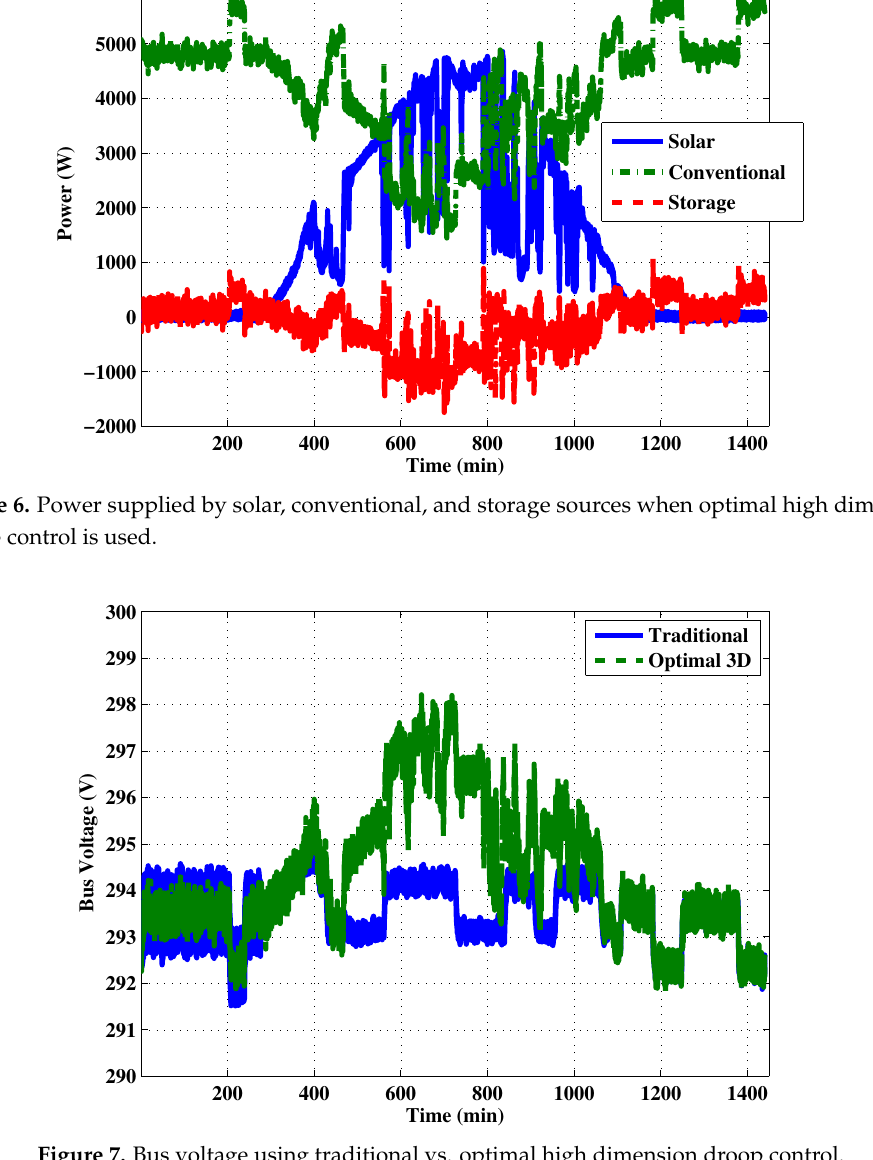
Figure 7. Bus voltage using traditional vs. optimal high dimension droop